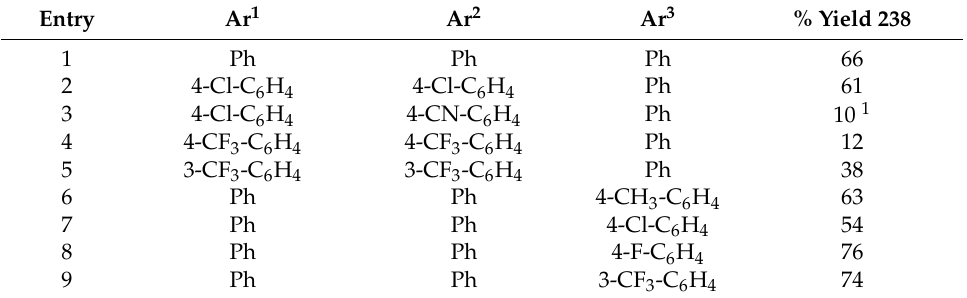
Table 31. The reaction of imines 223c , difluorocarbene and trifluoromethylketones 3 (Scheme